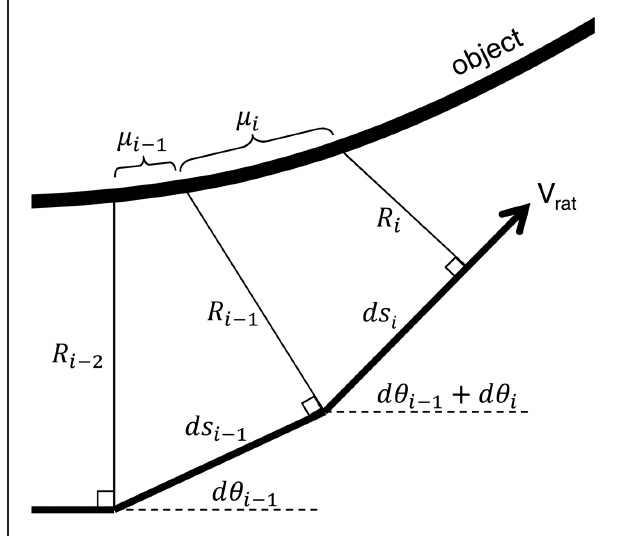
FIGURE 1 | Coordinate system for the determination of slope and curvature. At each time step, radial distance is calculated relative to the object. The rat’s velocity is indicated by V rat , and the arc s is always parallel to V rat . The distance ds i is the distance in the direction of s between discrete time measurements t i and t i − 1 . ds i − 1 is the distance in the direction of s between discrete time measurements t i − 1 and t i − 2 . R i is the radial distance measure at the i th time step, d θ i is an angle measure of the change in direction of V rat , and μ i represents the local slope of the